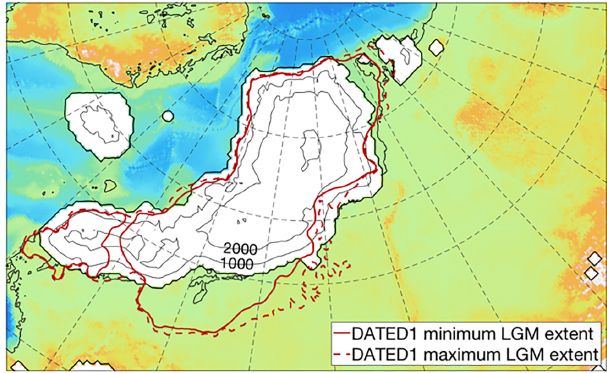
Figure 10. Comparison of the larger simulated Eurasian ice sheet at the LGM with the DATED-1 reconstruction (Hughes et al., 2016). Contour lines show ice thickness. The modelled ice sheet has a vol- ume of 24m sea-level equivalent, in agreement with the DATED-1 ice